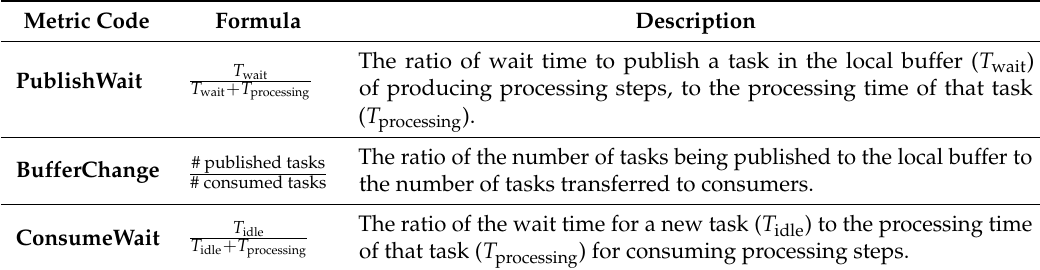
Table 1. Processing chain